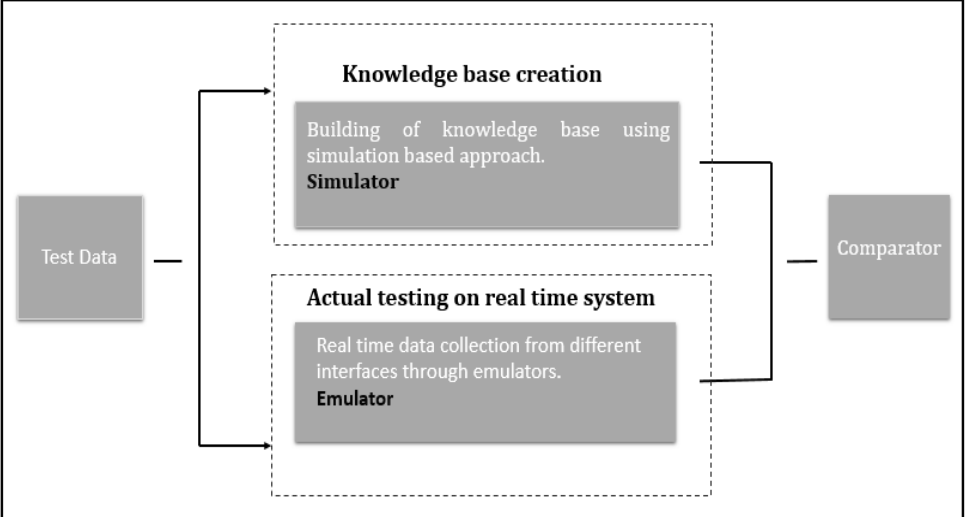
Figure 2. Steps of the proposed framework.